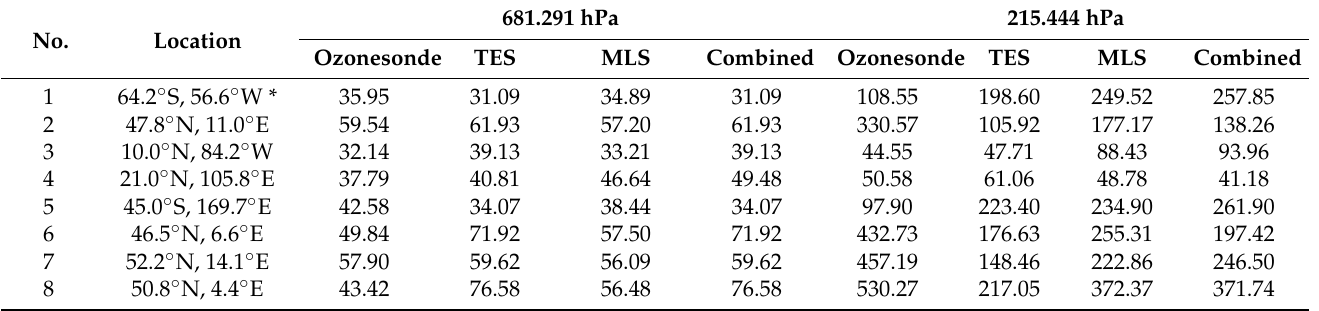
Table 1. Comparison between ozonesonde measurements and satellite products (interpolated) at 681.291 hPa and at 215.444 hPa for 8–9 July 2007. Unit: ppbv.